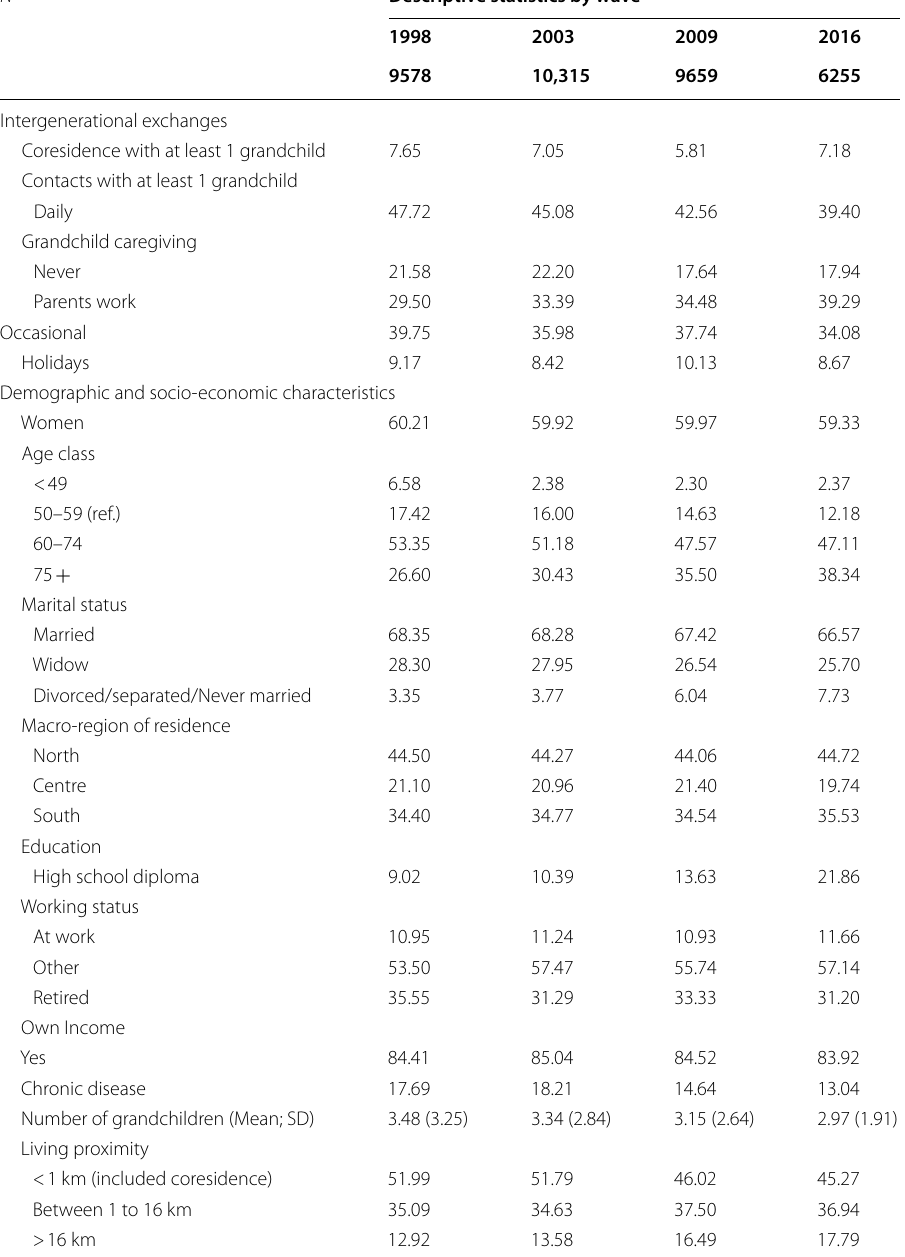
Table 1 Weighted descriptive characteristics of respondents by